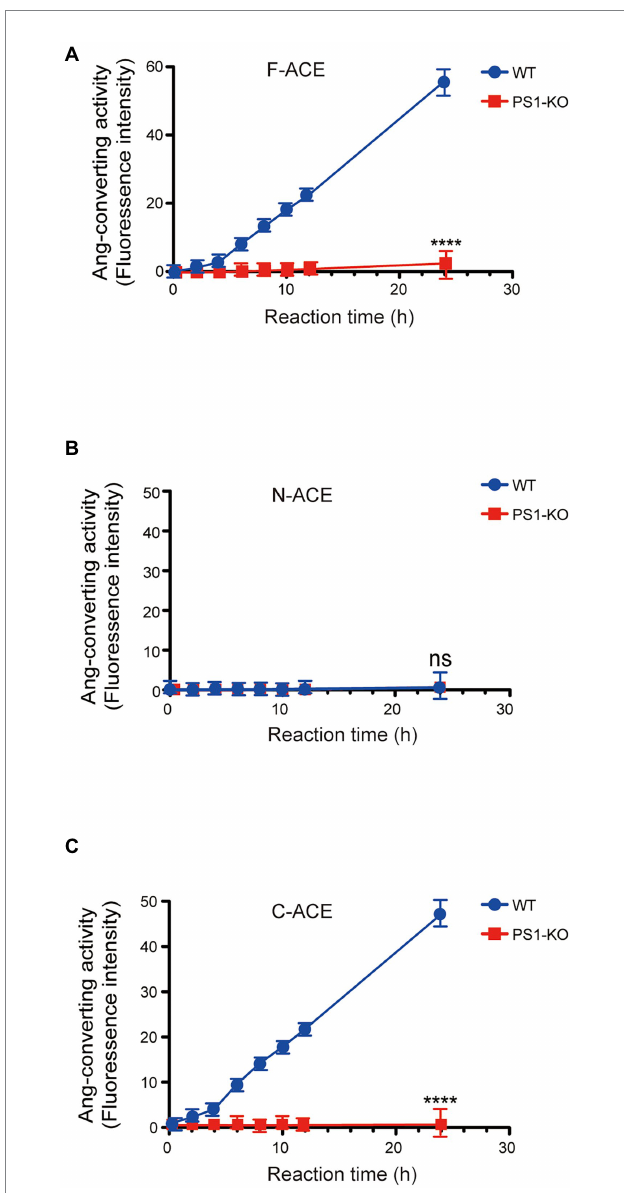
FIGURE 2 Loss of angiotensin-converting activity in recombinant F-and C-ACE from PS1-KO fibroblasts. Ang-converting (angiotensin-converting) activity was measured by incubating 2 μ g of ACE protein with the synthetic o-aminobenzoyl peptide substrate for 24 h at 37 ° C. (A) F-ACE purified from WT fibroblasts showed Ang-converting activity, whereas PS1-KO fibroblasts did not show any Ang-converting activity. (B) N-ACE purified from WT and PS1-KO fibroblasts did not show any Ang-converting activity. (C) C-ACE purified from WT fibroblasts showed Ang-converting activity, whereas PS1-KO fibroblasts did not show any Ang-converting activity. Values represent the means ± SD; n = 3; **** p < 0.0001. NS, not significant, by unpaired two-tailed Student’s t